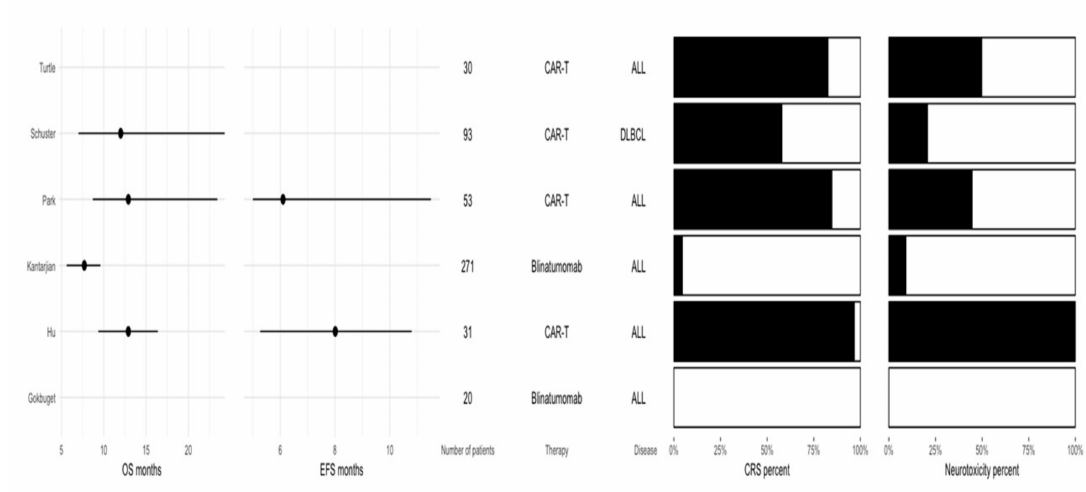
Figure 4. Summary of studies using either Blinatumomab or CAR-T cells as a therapeutic